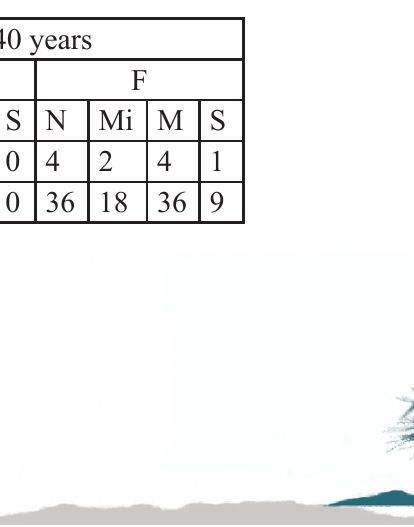
Table 3. Numbers and percentages of subjects falling into the various levels of dry eye. N indicates normal, Mi: mild dry eye, M: moderate dry eye and S: severe dry eye. Percentages have been rounded off and are